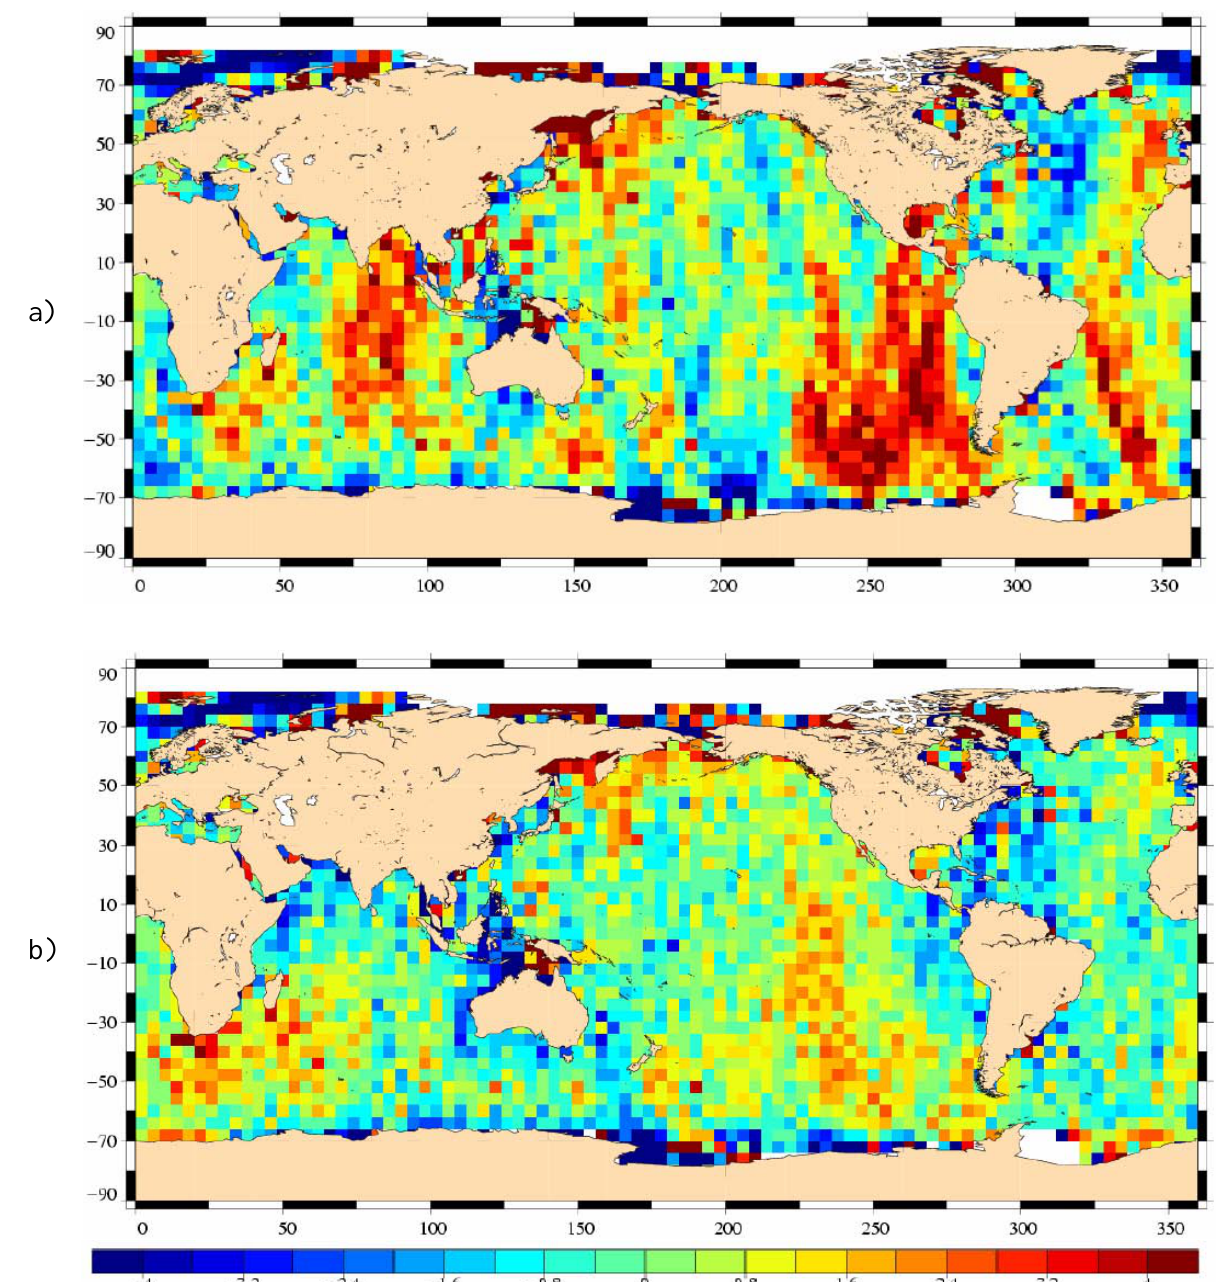
Figure 14. Maps of the time invariant 35-day crossover mean differences (cm) for Envisat averaged in (4deg x 4 deg) geographical bins through a one year period (cycle 25-35) a) using GDRs POE orbit (GRIM5 gravity model) and b) using Delft POE orbit (EIGEN-GRACE01S gravity